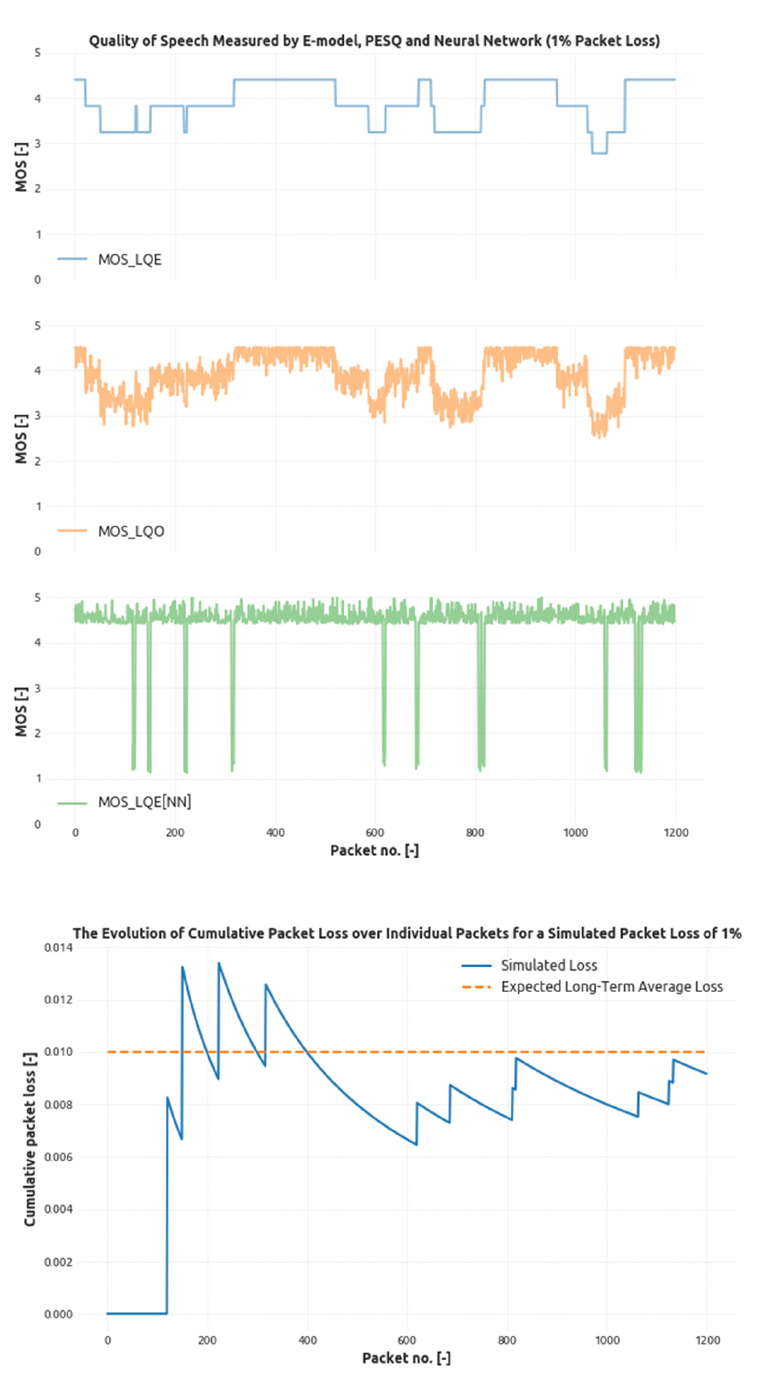
Figure 3. The evolution of the cumulative packet loss generated by the four-state loss model with given probabilities targeting the 1% loss threshold and related speech quality estimated by E-model, PESQ, and CNN.